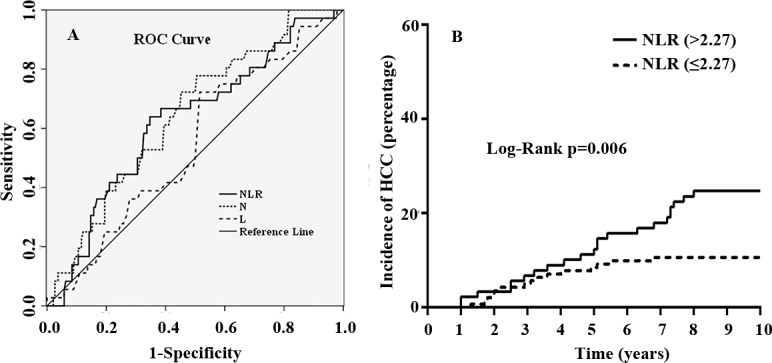
Preoperative neutrophil-to-lymphocyte ratio (NLR) and hepatocellular carcinoma (HCC) development in cirrhotic patients after splenectomy.A. a receiver operating characteristic (ROC) curve analysis of the predictive value of the preoperative NLR scores on hepatocarcinogenesis after splenectomy. The area under the ROC curve (AUC) was 0.625 (95% confidence interval, 0.527–0.723, P = 0.018). The calculated cut-off for NLR scores to predict HCC development was 2.27, with sensitivity of 63.9%, specificity of 65.3%, and Youden index of 0.292; B. a Kaplan-Meier plot for the association of the preoperative NLR score with the cumulative incidence of HCC after splenectomy. The difference between the two groups was compared by the Log-Rank test.